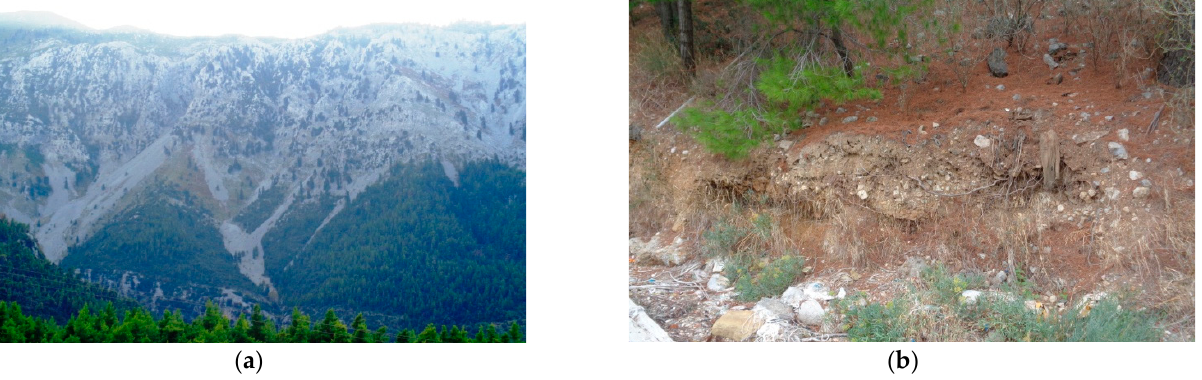
Figure 10. Field observations showing soil erosion ( a ) south of Pili village and ( b ) north of Limni village.